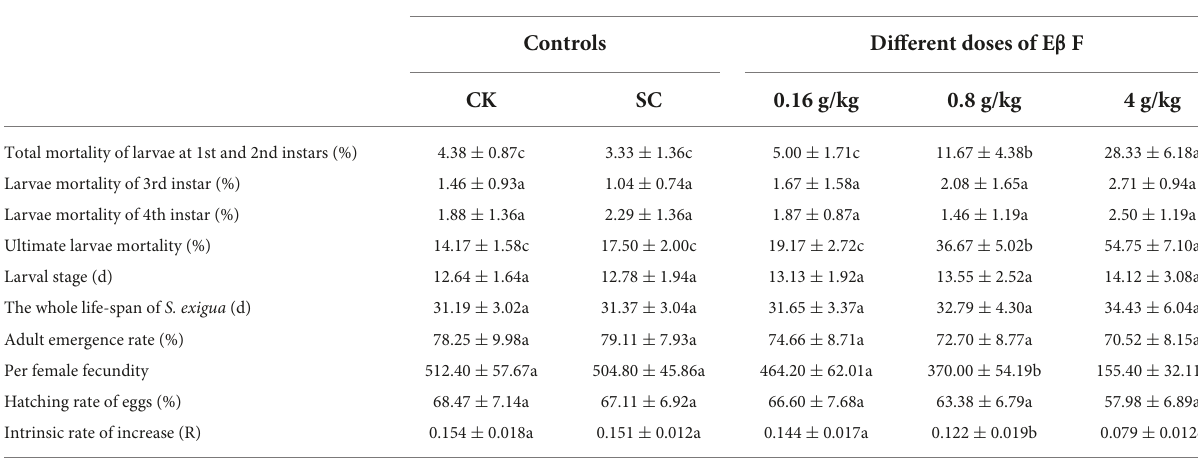
TABLE 1 The key life-history parameters of S. exigua larvae under different doses of E β F. Key life history parameters of S.